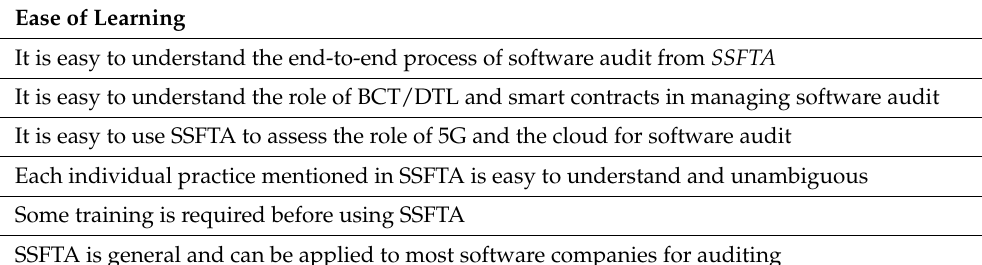
Table 3. The questions to evaluate SSFTA ease of learning.